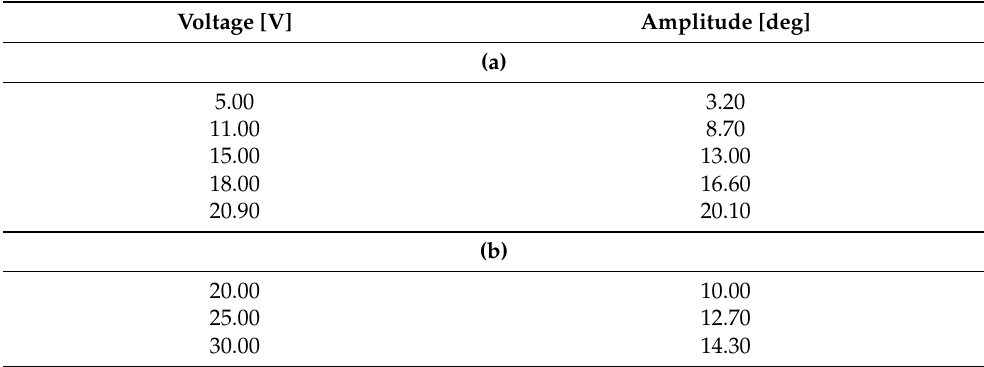
Table 1. Maximum opening angles at the resonance frequency of the torsional mode for different ac- tuation voltage amplitude. They are computed from experimental FRCs in Figure 3 for Micromirror 1 ( a ) and Micromirror 2 ( b